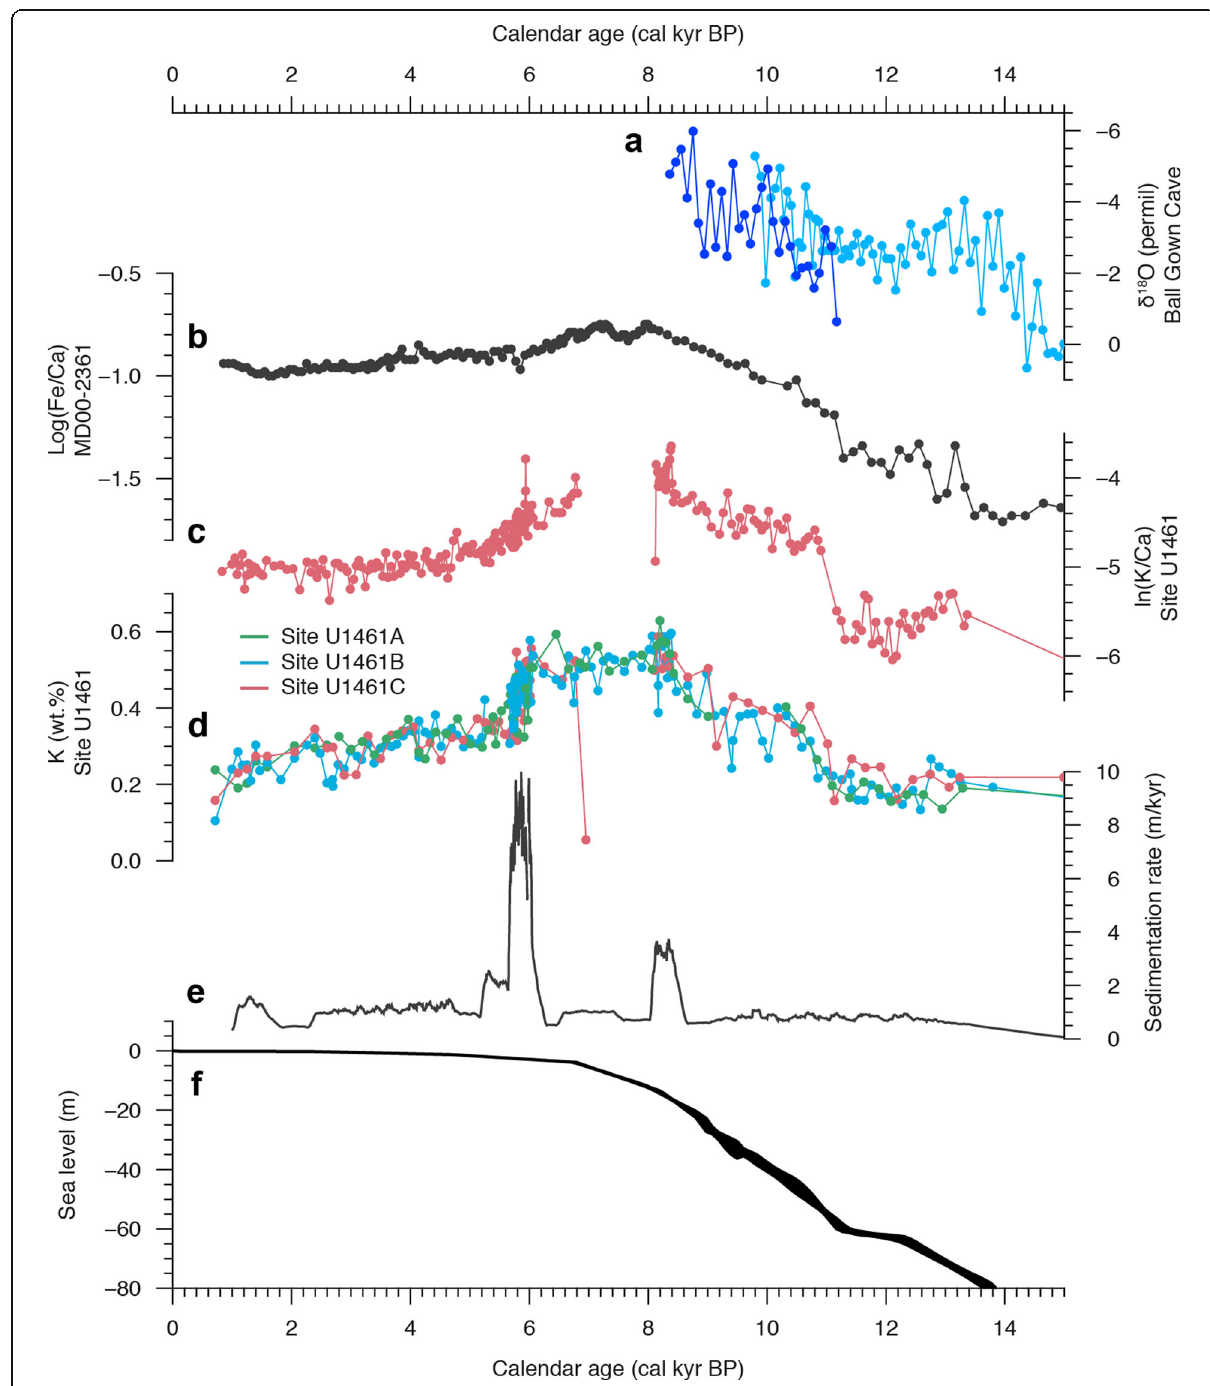
Fig. 4 Comparison of paleoclimatic records related to ASM variability in the past 15,000 years. a Ball Gown Cave stalagmite records (Denniston et al. 2013). b Fe/Ca records of core MD00-2361 recovered from the continental slope of Western Australia (Stuut et al. 2014). c K/Ca records obtained from Site U1461. d %K at Site U1461 measured by shipboard NGR measurement. e Sedimentation rate of Site U1461 established by the Bchron model. f Global sea level curve from Lambeck et al.